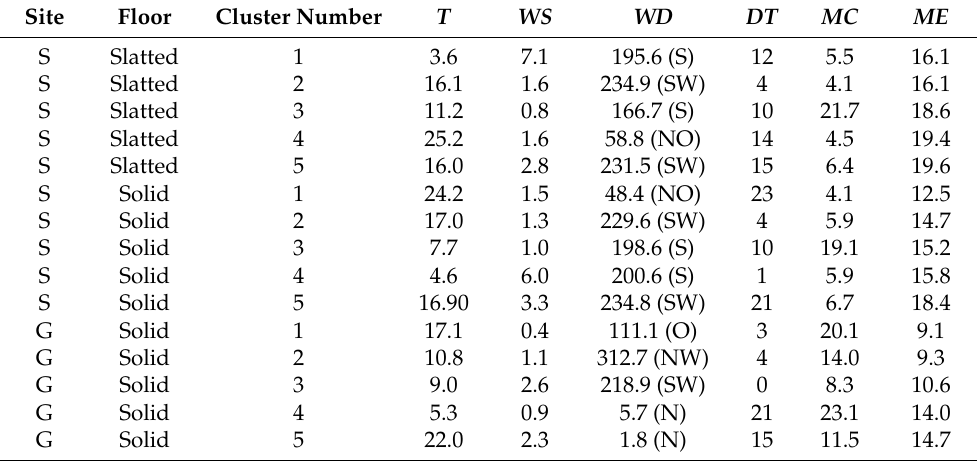
Figure 6. Clustering of air temperature (T) in ◦ C, wind speed (WS) in ms − 1 , wind direction (WD) in ◦ , daytime (DT) in h, CH 4 concentration (MC) in ppm and CH 4 emission (ME) in gh − 1 LU − 1 in the data set of the solid floor system in Germany. The abbreviations on the diagonal indicate which variables are displayed at the axes in the respective row and column of the plot. Cluster affiliation is color-coded in the scatter plots in the lower triangle in violet, blue, green, orange and red (ordered from low median of emission to high median of emission in the cluster). The upper triangle shows the related Spearman rank correlation values for the individual clusters in the same color code. Table 7. Median values of air temperature ( T ) in ◦ C, wind speed ( WS ) in ms − 1 , wind direction ( WD ) in ◦ , daytime ( DT ) in h, CH 4 concentration ( MC ) in ppm and CH 4 emission ( ME ) in gh − 1 LU − 1 within the individual clusters. The median values were extracted from the normalized and sinus- transformed values in the case of wind direction and daytime and then transformed back. For the wind direction, the associated wind corridor is mentioned in